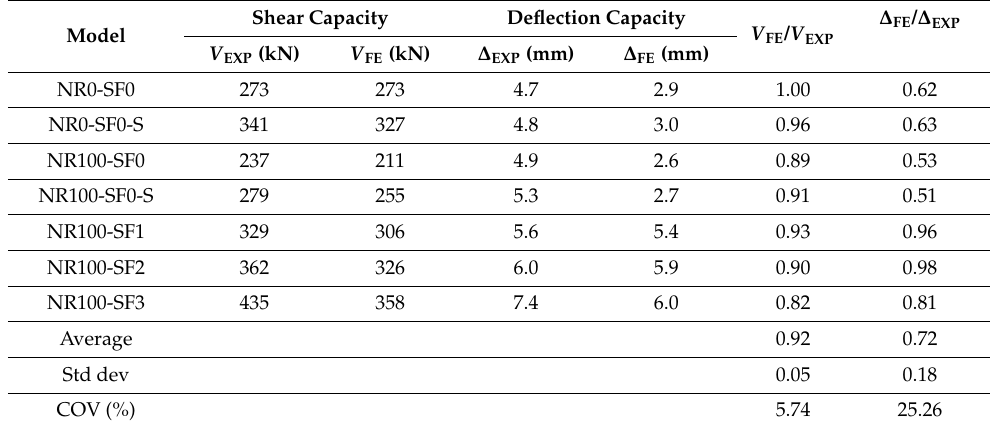
Table 4. Comparison between numerical and experimental results of group N.